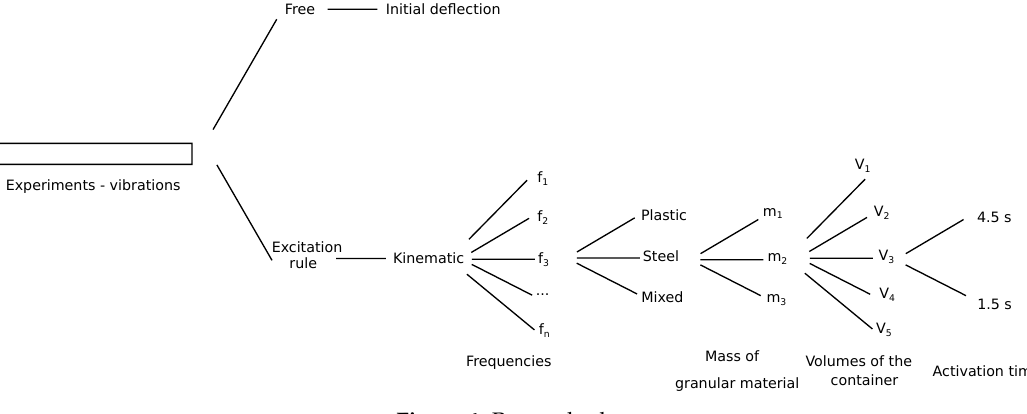
Figure 4. Research plan.